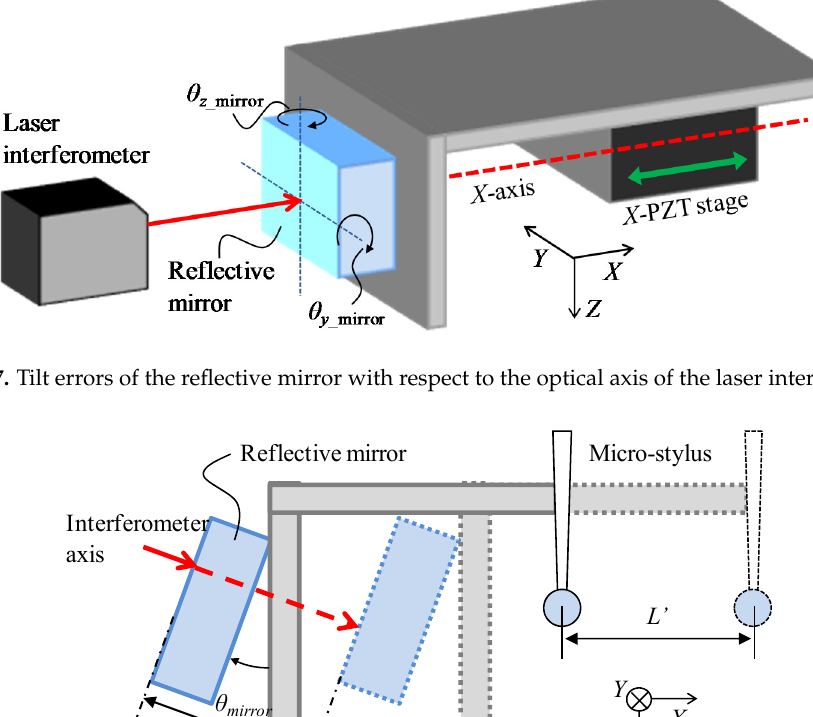
Table 1. Summary of the angular alignment errors of the positioning stages.